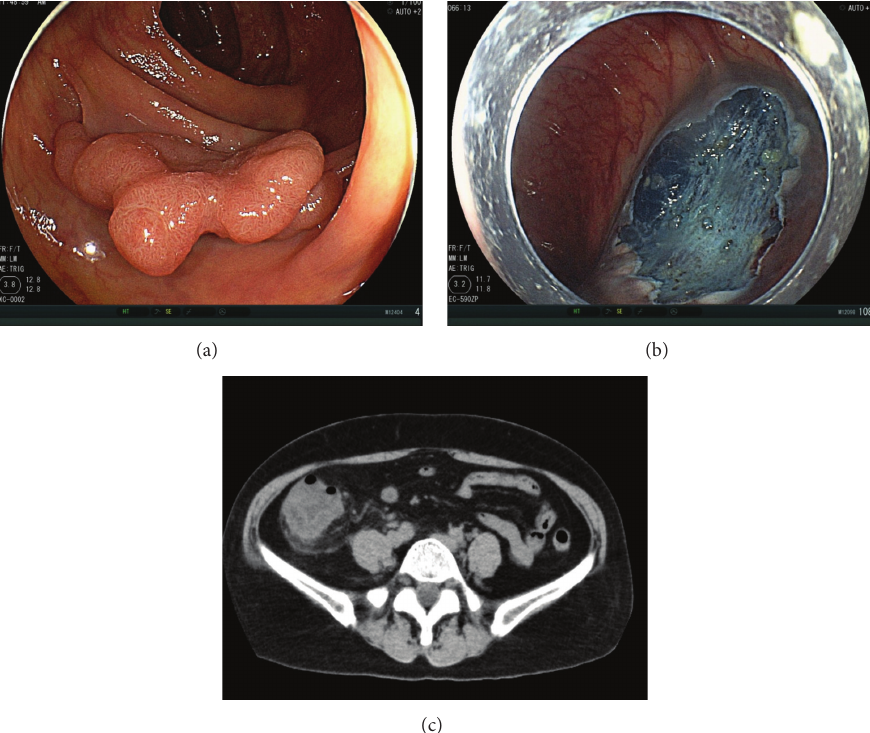
Figure 7: (a) Colonic tumor, 0-IIa, 40mm in diameter, located in the ascending colon. (b) The ulceration after endoscopic submucosal dissection (ESD). ESD was performed without perforation and coagulation of the muscle layer. (c) Abdominal computed tomography 2 days after ESD revealed wall thickness on the whole ascending